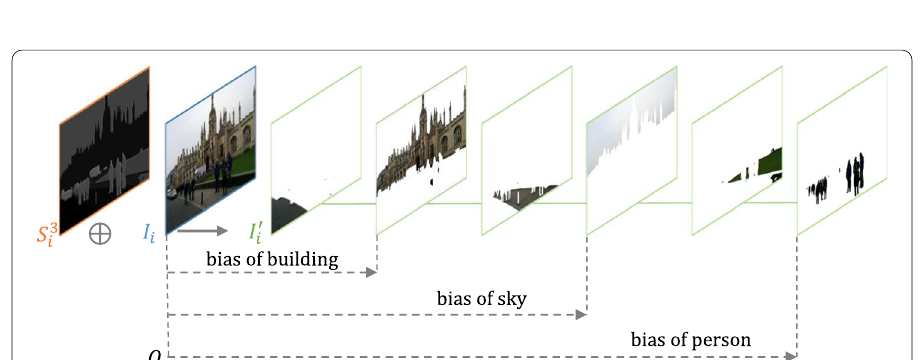
Fig. 3 The architectures of the proposed modules. a The bias network, composed of three convolutional layers. b The attention network, composed of a residual network with one Convolutional Block Attention Module